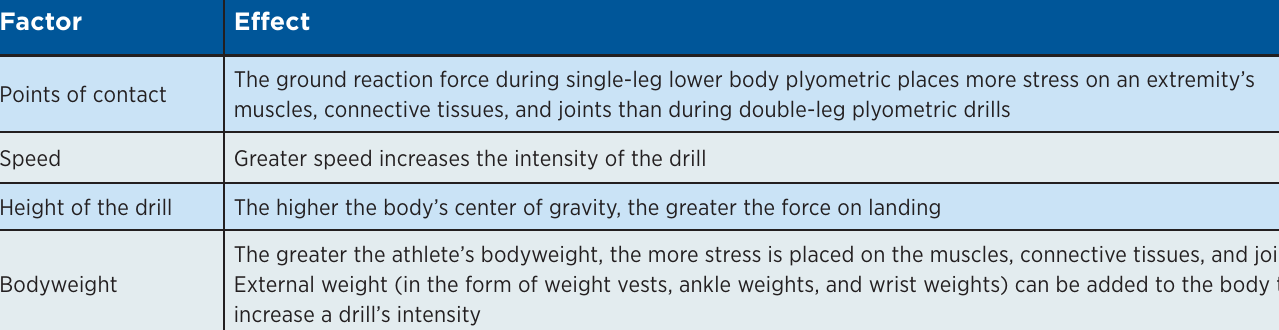
Figure 5-2. Plyometric Intensity